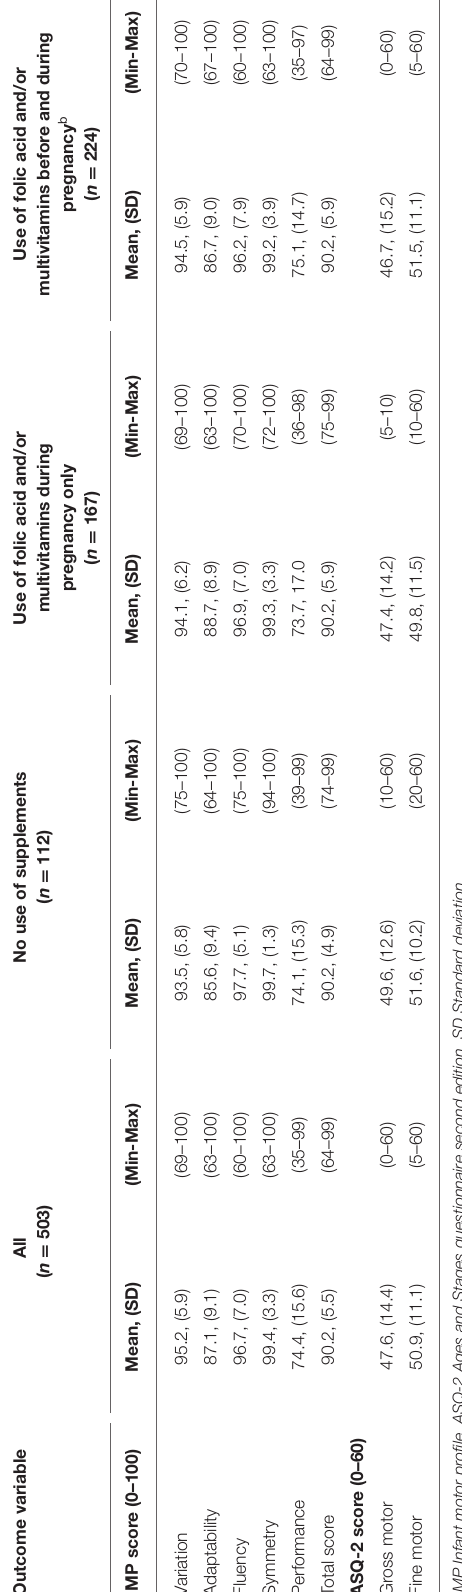
TABLE 3 | Associations of folic acid-containing supplement use with motor function.